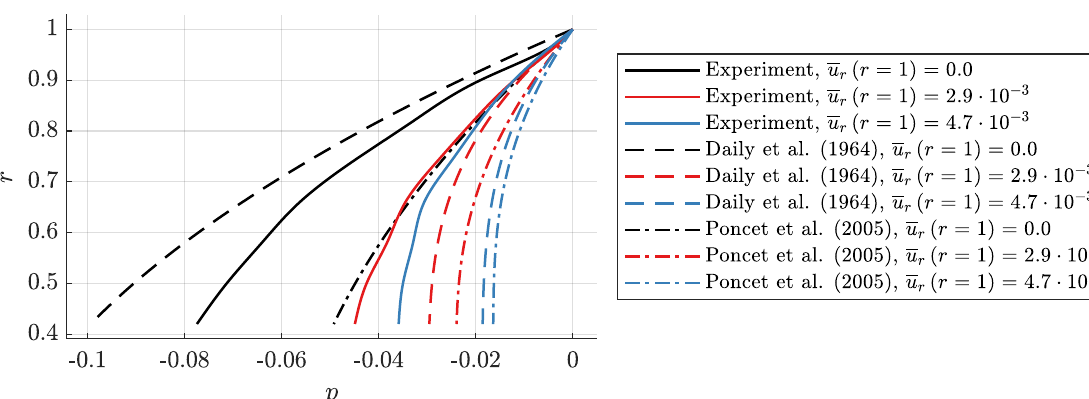
Figure 6. Comparison of the average fluid rotation factor models (2) and (3) by Daily et al. [2] and Poncet et al. [4], respectively, with measurements at the high Reynolds number of 2.5 · 10 8 and an axial cavity width of